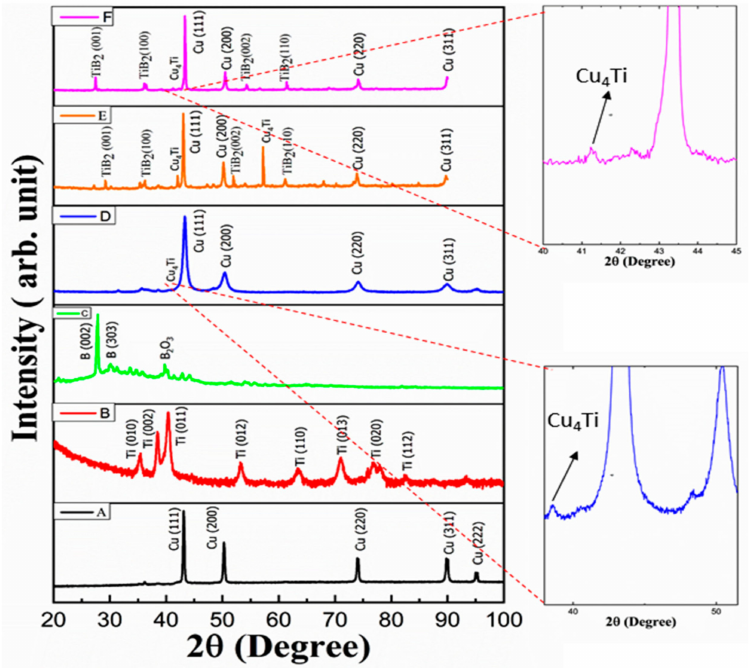
Figure 8. XRD of ( A ) pure Cu, ( B ) Ti, ( C ) B, ( D ) milled powder with composition (Cu-5B-10Ti), ( E ) compacts with composition Cu-2B-4Ti, and ( F )